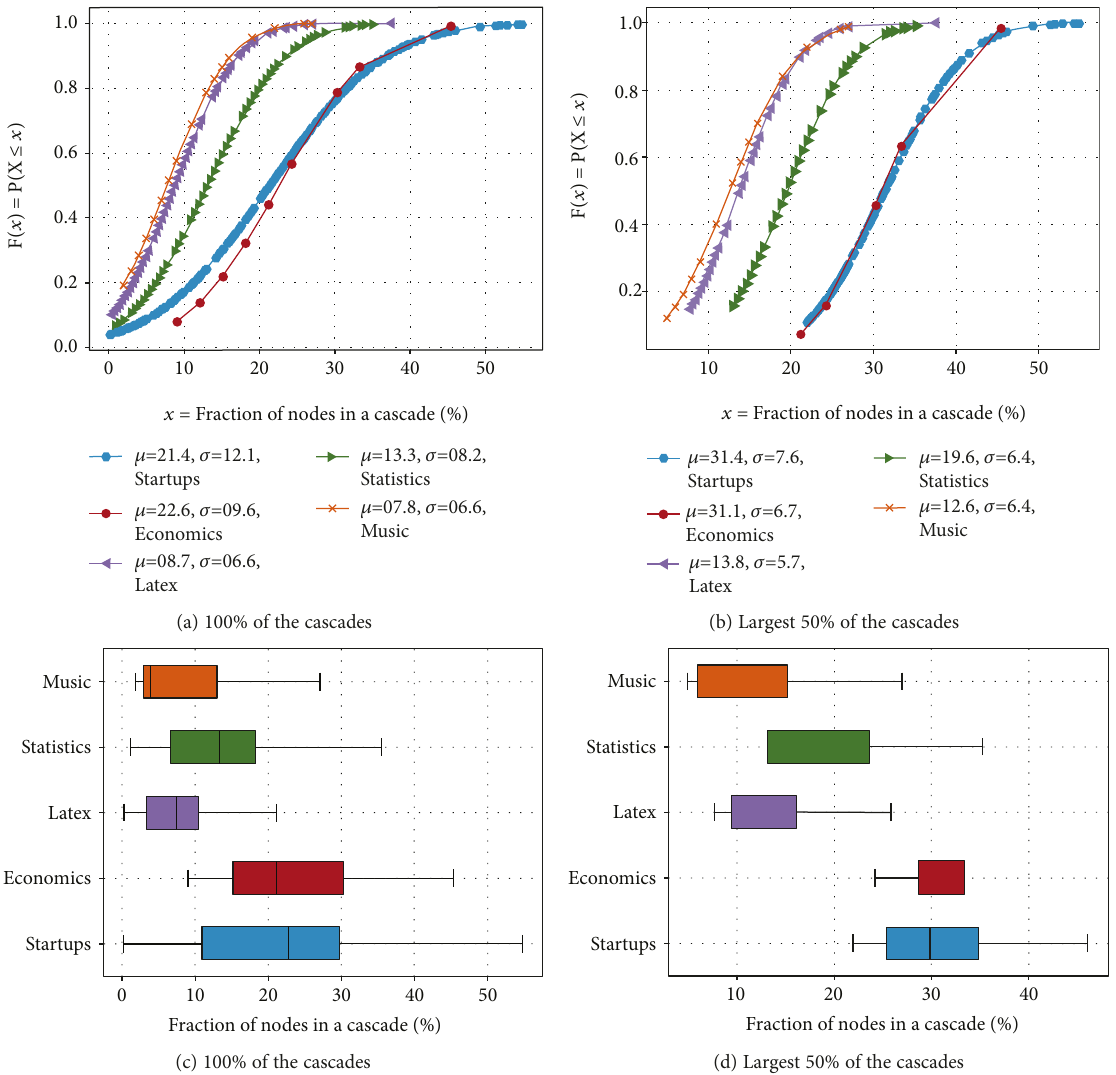
Figure 2: The fi gure shows the fraction of nodes (of the initial network) in the observed cascades as CDF (a and b) and as box plots (c and